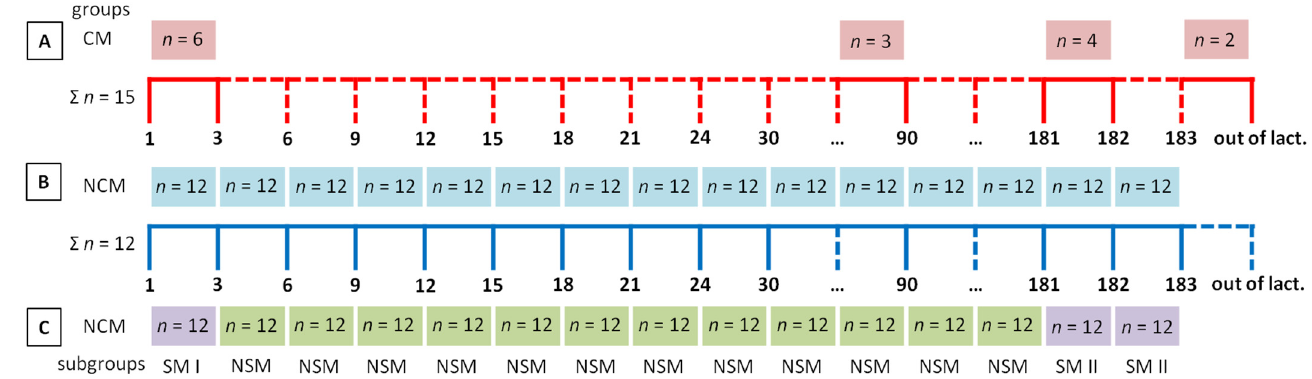
Figure 1. A designee of the study including the number of samples ( n ), days of lactation (1, 3, 6, 9, 12, 15, 18, 21, 24, 30, 90, 181, 182, 183), days out of lactation (out of lact.), a sum of mares in the group ( Ʃ n), group names (CM, group with clinical symptoms of mastitis; NCM, group with no clinical symptoms of mastitis), subgroup names (SM I, SM II, group with subclinical symptoms of mastitis; NSM, group with no subclinical symptoms of mastitis). Sampling in the group with clinical symptoms of mastitis ( A ). Sampling in the group with no clinical symptoms of mastitis ( B ). Dividing the group with no clinical symptoms of mastitis into two subgroups, the first with subclinical symptoms of mastitis and the second with no subclinical symptoms of mastitis based on the results of the studied measurements ( C ).